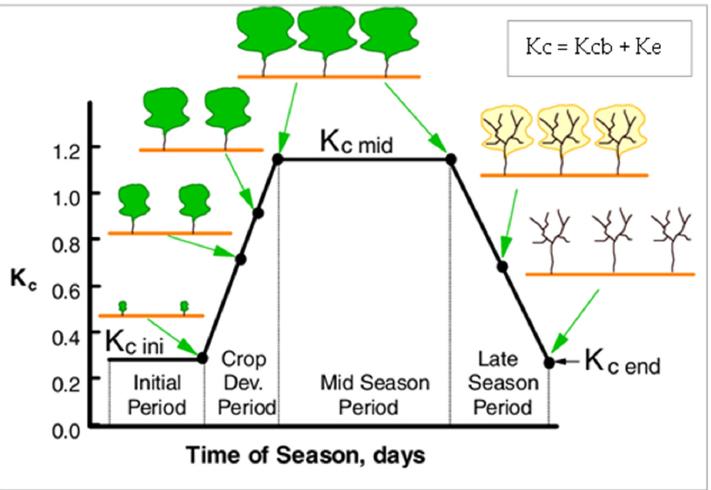
Figure 4. Evolution of the cultural coefficient, Kc, during the growth stages of the crop [12]. The evapotranspiration was estimated using satellite monitoring of irrigation (SAMIR) software, which allows the spatialization of evapotranspiration (ET) and water balance of irrigated crops over large areas [22,42]. The architecture of this program is based on the FAO-56 model. It calculates the reference evapotranspiration, ET0, from cli- matic data. In addition to that, the basal crop coefficient, Kcb, was determined by a time series of daily NDVIs after the interpolation between the dates of acquisition of the satel- lite images [15]. In addition to the spatialization of ET, SAMIR can be used to determine the crop water balance, which is obtained by coupling a soil module of three compart- ments (surface, root, and depth) to the FAO-56 model. The FAO-56 tables [12] provide values of the crop coefficient according to the crops. In parallel to this approach, many studies have highlighted the relationship between NDVI and the crop coefficient [15,17–19,23]. The calculation of the water balance requires climatic data to estimate the reference evapotranspiration, ET0, precipitation, soil data, and irrigation data, as well as the crop type map and vegetation phenology (to estimate crop coefficients with the FAO-56 method). Irrigation data can be used in two ways: if they are available, they are used di- rectly, and if not, they are estimated from the water balance calculation [43]. In this work, water quantities, as well as irrigation dates, were available. Concerning the soil data, three functional compartments can be configured: evaporative, root, and depth. Each compart- ment is characterized by its depth, field capacity, wilting point, diffusion coefficient, and saturation humidity. In addition, a soil type map can also be used. In our case, the data used were those published by the Food and Agriculture Organization of the United Na- tions (FAO) [12,43]. 2.3. Crop Type Mapping The methodology adopted for the realization of the crop type map is illustrated in Figure 5. The support vector machines (SVM) method was used for the classification of the multitemporal satellite dataset. A field survey was carried out to collect the reference data (120 samples); fifty percent of them were used for training the classification and checking the spectral profiles of the different crops in the study area, while the other fifty percent were used for the validation of the classification results.